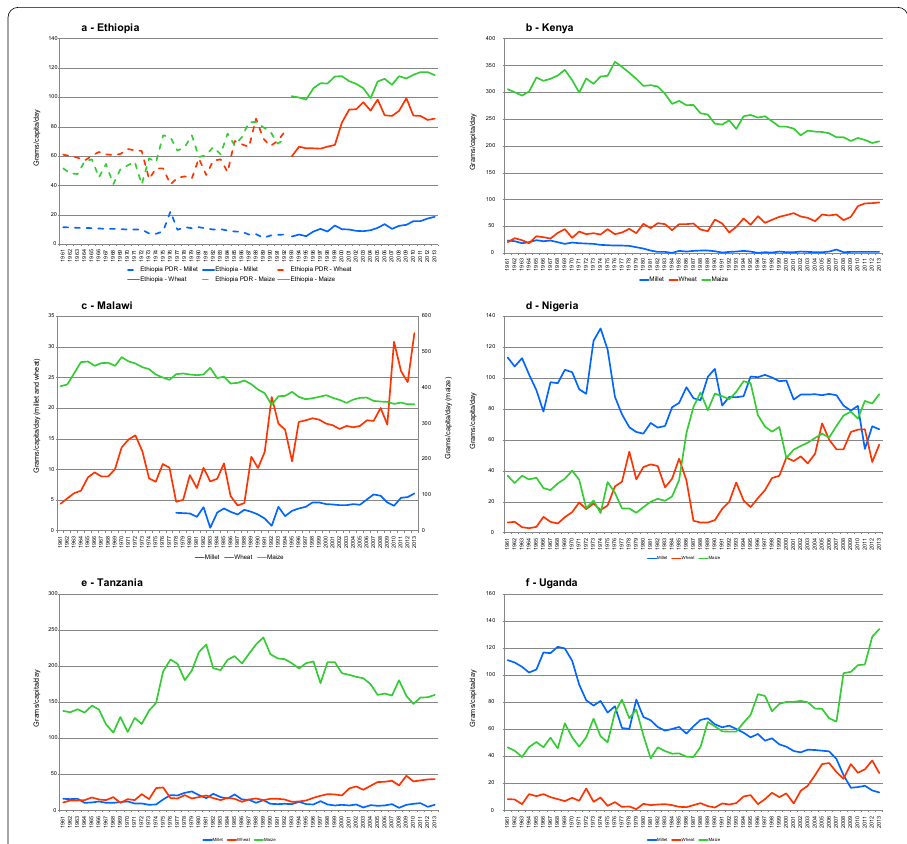
Fig. 1 Apparent per capita per day consumption of millet, maize and wheat and their products in selected Sub Saharan African countries. Source : Based on FAOSTAT